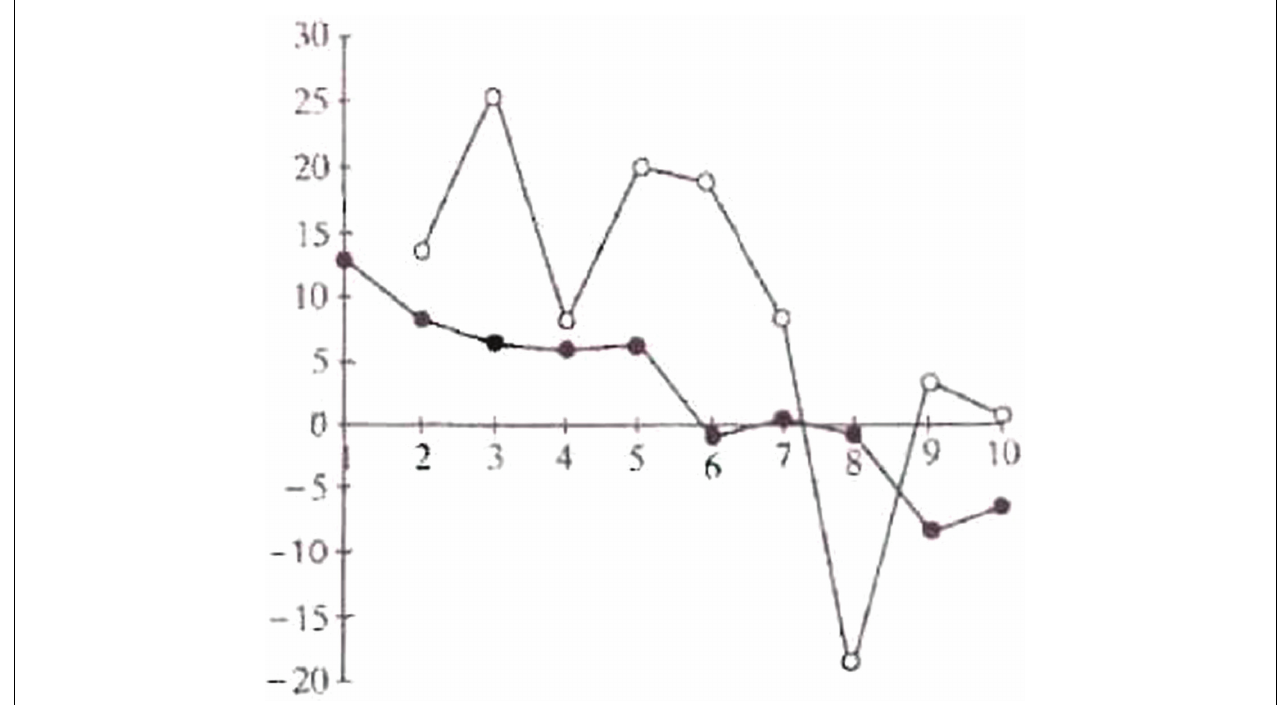
FIGURE 2 | Pre- and PH2Armed Forces QualificationTest (AFQT) scores in head injured subject (filled circles, r =− 0.32) and controls (open circles, r =− 0.44). Plot of pre- to PH2 AFQT differences (D-AFQT) by preinjury AFQT deciles.